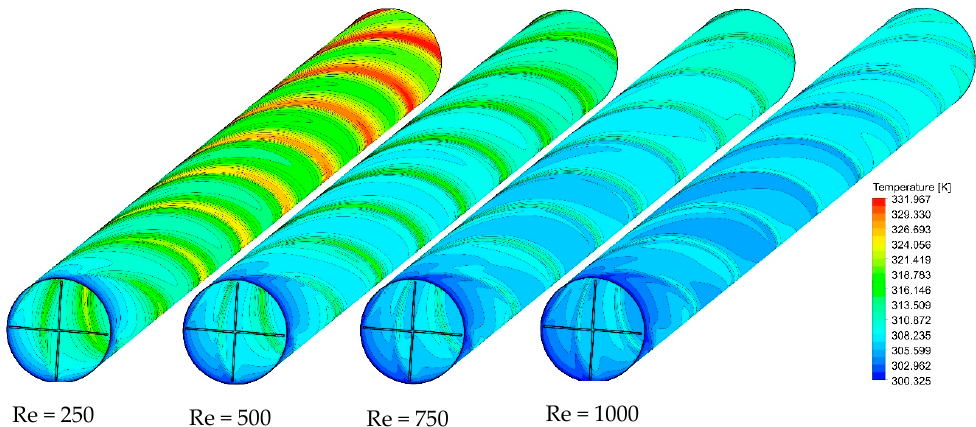
Figure 15. Temperature contours on the heated wall for Case 5 at different Re numbers and φ = 0%.